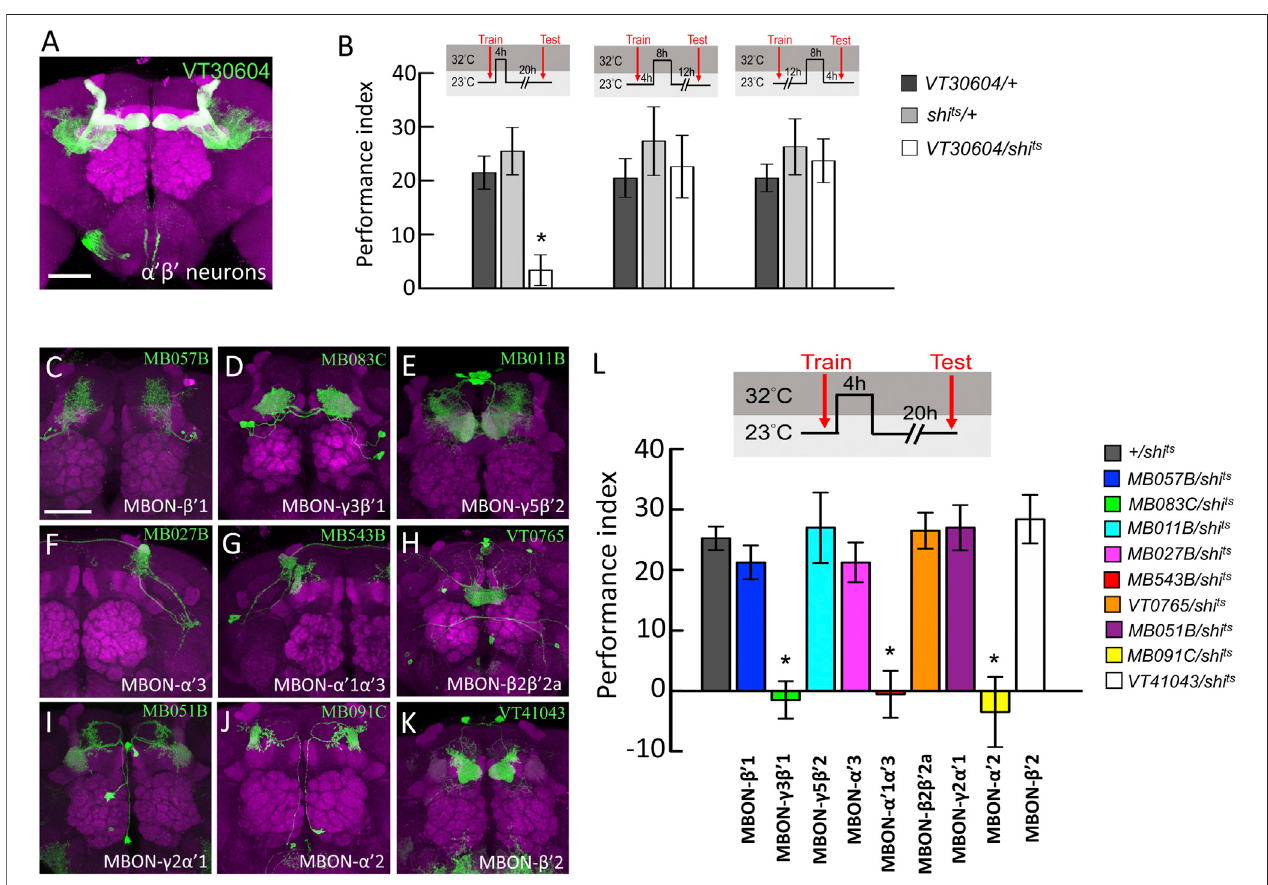
FIGURE 1 | Behavioral screen to identify α ′ β ′ -MBONs necessary for wLTM consolidation. (A) The expression pattern of VT30604-GAL4 (green). The brain was immunostained with anti-DLG antibody (magenta). Scale bar, 50 μ m. (B) Blocking neurotransmitter output in α ′ β ′ neurons at 0 – 4 h period after training disrupted the wLTM (left panel). Blocking neurotransmitter output in α ′ β ′ neurons at 4 – 12 h period after training did not affect the wLTM (middle panel). Blocking neurotransmitter output in α ′ β ′ neurons at 12 – 20 h period after training did not affectthe wLTM (right panel). Each value represents mean ± SEM (N (cid:1) 8, 8, 8, 8, 8, 8, 10, 10, and 10 from left to right bars). * p < 0.05; one-way ANOVA followed by Tukey ’ s test. (C) The expression pattern of MB057B-GAL4 -driven GFP in MBON- β ′ 1 neurons. (D) The expression pattern of MB083C-GAL4 -driven GFPin MBON- γ 3 β ′ 1 neurons. (E) Theexpression pattern of MB011B-GAL4 -drivenGFPin MBON- γ 5 β ′ 2 neurons. (F) The expression pattern of MB027B-GAL4 -driven GFP in MBON- α ′ 3 neurons. (G) The expression pattern of MB543B-GAL4 -driven GFP in MBON- α ′ 1 α ′ 3 neurons. (H) The expressionpatternof VT0765-GAL4 -drivenGFPinMBON- β 2 β ′ 2a. (I) Theexpressionpatternof MB051B-GAL4 -drivenGFPinMBON- γ 2 α ′ 1, (J) Theexpressionpattern of MB091C-GAL4 -driven GFP in MBON- α ′ 2, and (K) The expression pattern of VT41043-GAL4 -driven GFP in MBON- β ′ 2. All the brains were immunostained with anti- DLG antibody (magenta). Scale bar, 50 μ m. (L) Blocking neurotransmission in MBON- γ 3 β ′ 1, MBON- α ′ 1 α ′ 3, and MBON- α ′ 2 using shi ts during memory consolidation disrupted wLTM. Each value represents mean ± SEM (N (cid:1) 29, 8, 10, 8, 8, 9, 8, 8, 8, and 10 from left to right bars). * p < 0.05; one-way ANOVA followed by Tukey ’ s test.